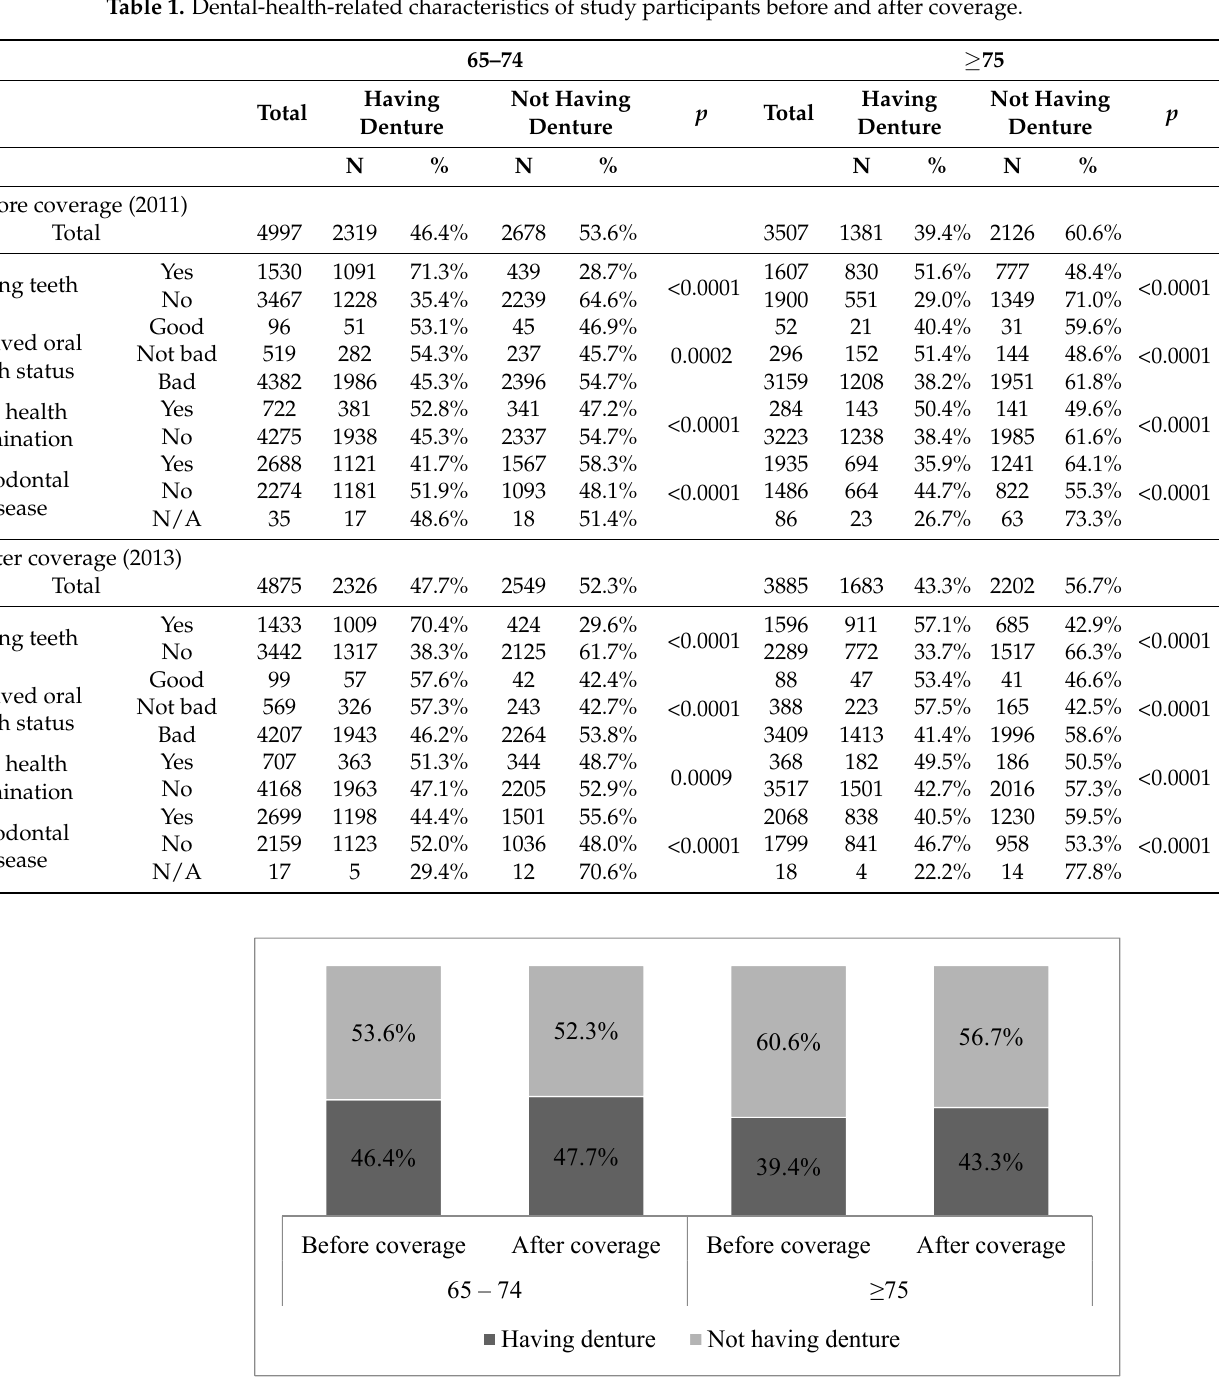
Figure 1. Change in denture procedure for the elderly before and after coverage ( p < 0.0001).